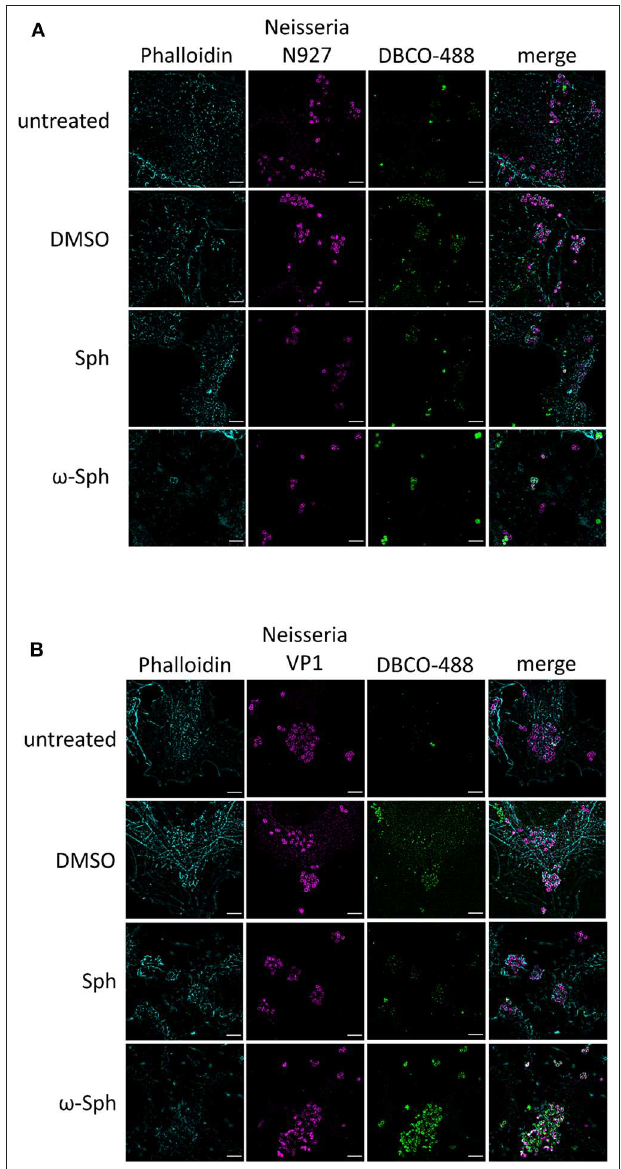
FIGURE 6 | Incorporation of ř -azido-sphingosine in different infection models. Chang and End1 cells were fed either with clickable sphingosine-analog (10 µ M ř -azido-sphingosine, ř -Sph), sphingosine (10 µ M, Sph) or DMSO as solvent control. Cell were then infected for 4h and the click reaction with dye DBCO-488 was performed. Cells were stained for actin cytoskeleton (Phalloidin) and Neisseria were immunolabeled. (A) Infection of End1 cells with the strain N927. (B) Infection of Chang cells with the clinical strain VP1. Bars 5 µ m.